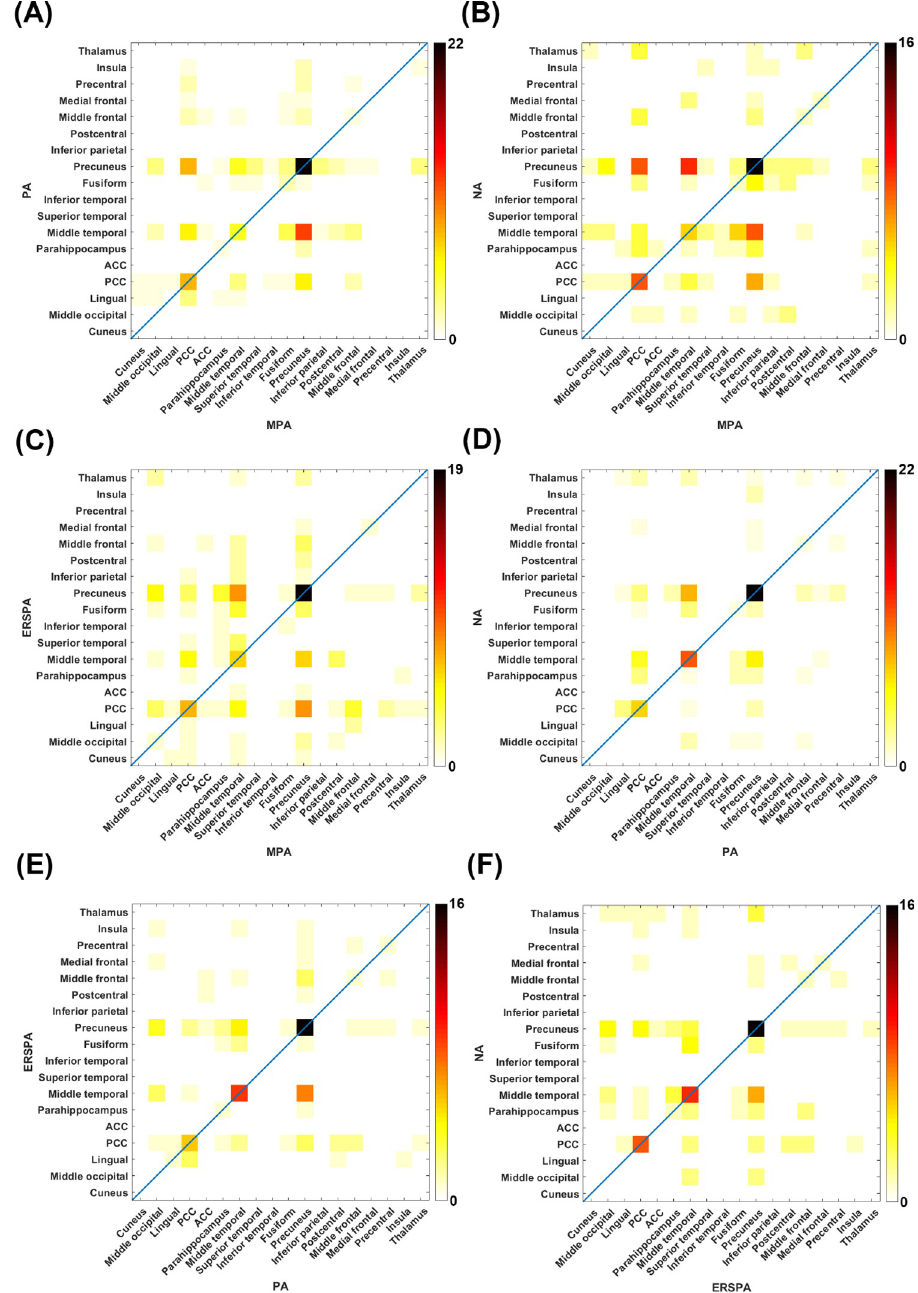
Fig 5. Agreement plots for dipole source localization between each method. The (A) MPA and PA, (B) MPA and NA, (C) MPA and ERSPA, (D) PA and NA, (E) PA and ERSPA, and (F) NA and ERSPA methods. Note that good agreement is observed mainly in the precuneus, PCC and middle temporal gyrus. MPA, max peak average; PA, positive average; NA, negative average; ERSPA, event-related spectral perturbation average; PCC, posterior cingulate cortex; ACC, anterior cingulate